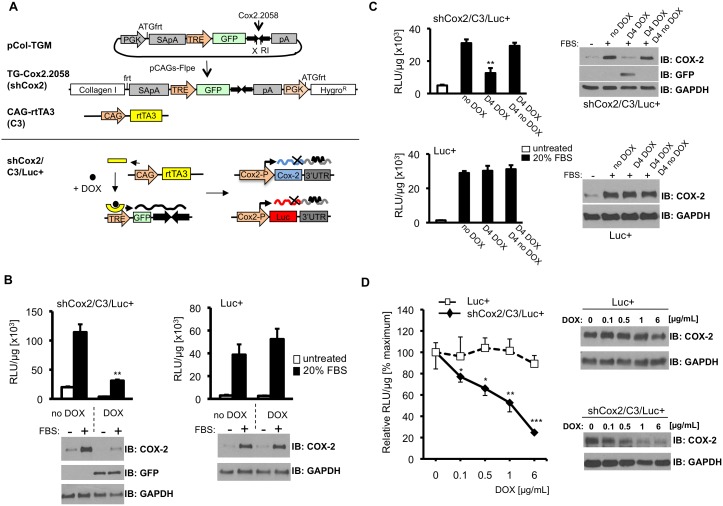
Inducible COX-2 shRNA expression suppresses Cox2-driven gene expression in cells cultured from triple transgenic mice.(A) Upper panel: The diagram shows the pCol-TGM targeting construct encoding GFP and COX-2 shRNA, expressed from a TRE promoter. Co-electroporation, with pCAGS-Flpe recombinase, into KH2 ES cells results in integration of the construct into the ColA1 locus. ShCox2 mice are crossed with tet-transactivator mice (CAG-rtTA3/C3) to create double trangenics. Lower panel; in triple transgenic shCox2/C3/Luc+ mice, DOX-rtTA3 activates the TRE promoter, driving GFP and shCox2 expression; shCox2 blocks COX-2 and luciferase expression. Without DOX the TRE promoter is quiescent; COX-2 and luciferase are expressed normally. (B) Inducible suppression of Cox2 gene expression in fibroblasts. Skin fibroblasts from triple transgenic shCox2/C3/Luc+ and Luc+ mice were cultured for four days in the absence or presence of DOX (1 µg/mL), shifted to 1% serum overnight, then stimulated with 20% serum for 6 hours. Luciferase activity was measured in extracts, COX-2 and GFP protein were analyzed by Western blot. Luciferase activity was normalized to protein content. (C) Reversible suppression of Cox2 gene expression in skin fibroblasts. Cells were untreated (no DOX), treated for 4 days with DOX (D4 DOX), or treated for 4 days with DOX followed by 4 days without DOX (D4 DOX, D4 no DOX). Cells were stimulated with medium containing 20% FBS; luciferase activity, COX-2 expression and GFP expression were analyzed. (D) Bone marrow macrophages from shCox2/C3/Luc+ and control Luc+ mice were cultured in the indicated concentrations of DOX overnight, then stimulated for 4 hours with LPS (50 ng/mL) to induce COX-2. Cell extracts were analyzed for luciferase activity and COX-2 protein. Luciferase activities are normalized to LPS stimulation in the absence of DOX. Data are means +/− SD. Statistics compare DOX-treated cultures with cells not receiving DOX (*, p<0.05; **, p<0.01; ***, p<0.001).